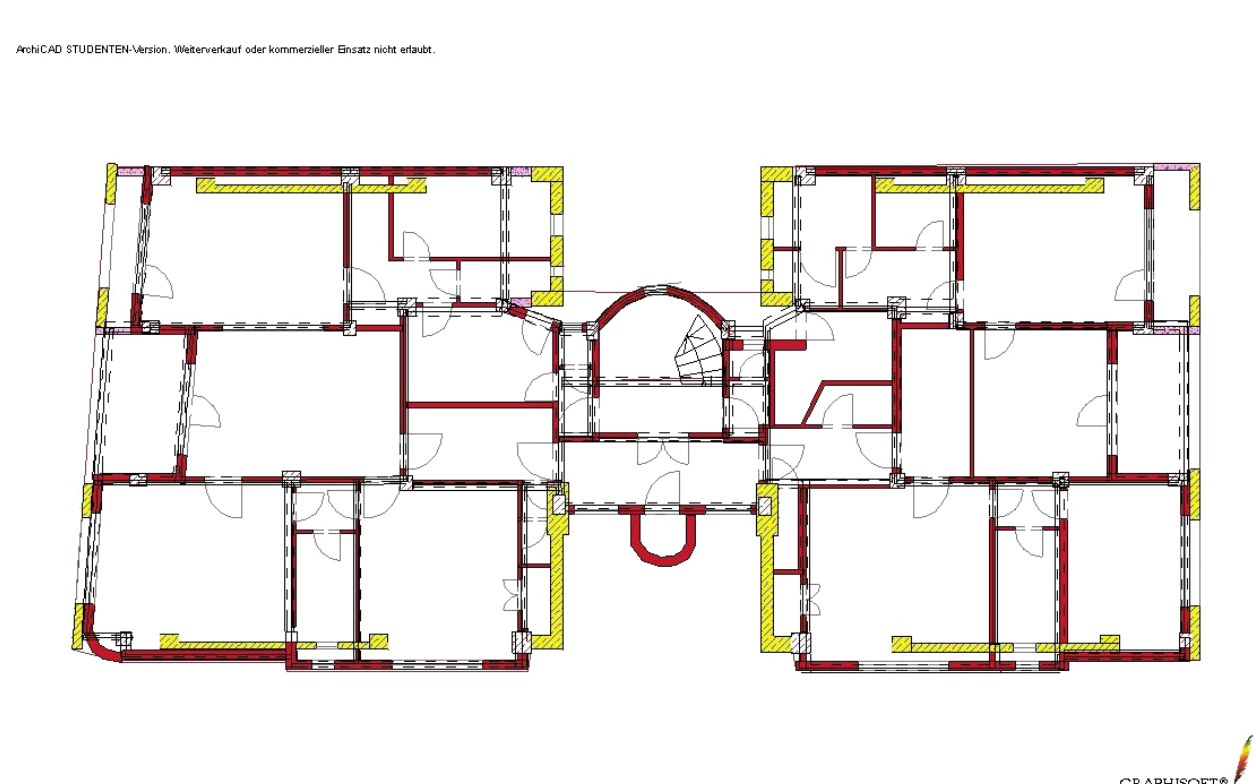
Figure 4. Typological studies.